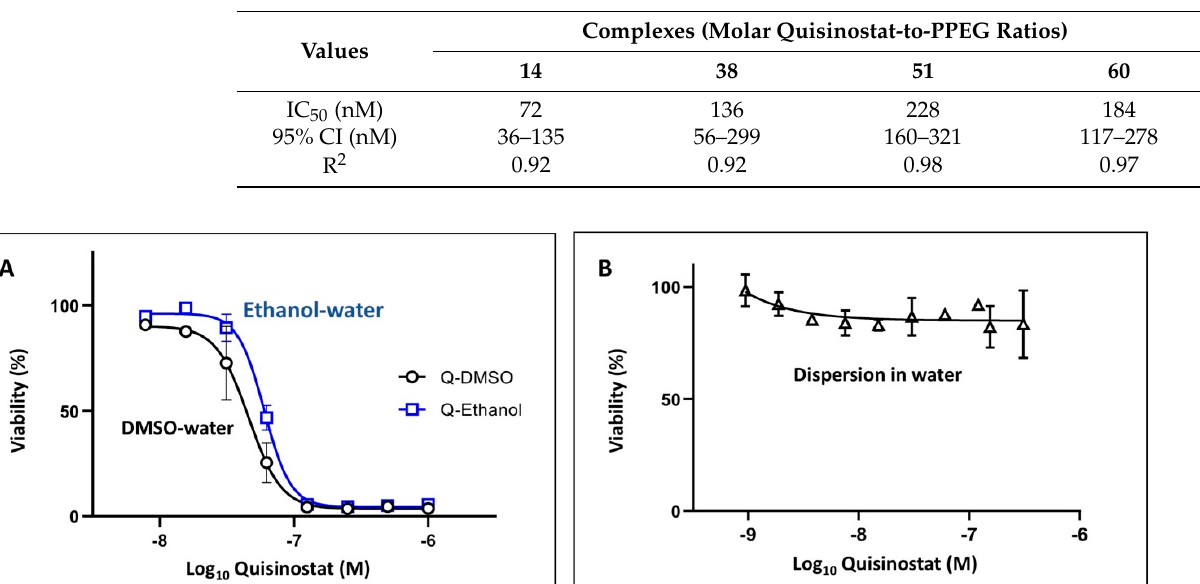
Figure A3. Representative dose–cell viability curves for quisinostat ( A ) dissolved in DMSO-water or ethanol-water mixtures and ( B ) dispersed in water (WM115 human melanoma cell line; 72 h, n = 3; points represent the mean values with errors indicating standard deviation).